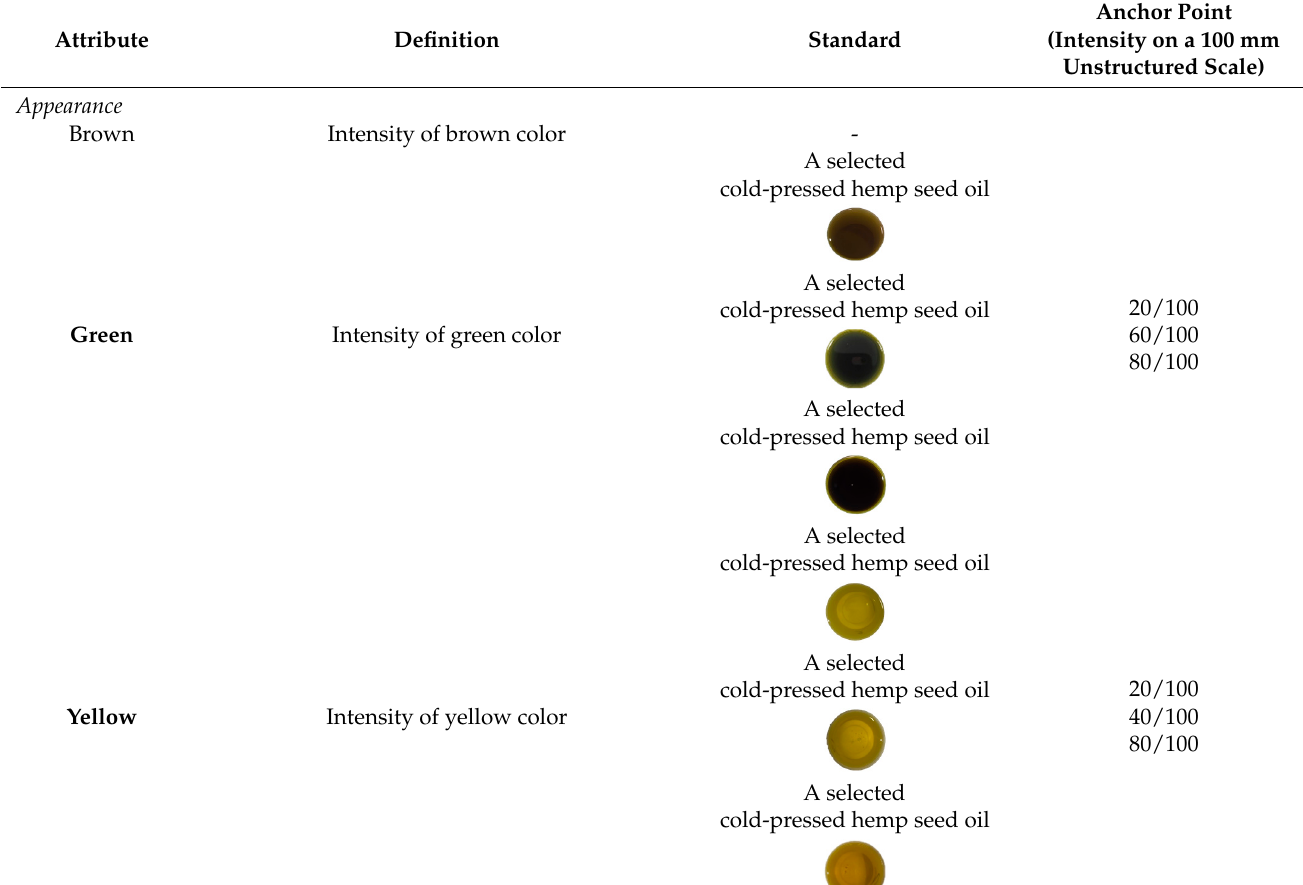
Table 1. Consensus list of attributes describing appearance, aroma, flavor, taste, and mouthfeel sensations of samples. Attributes in bold were used to construct the sensory profile sheet for cold- pressed hemp seed oils.